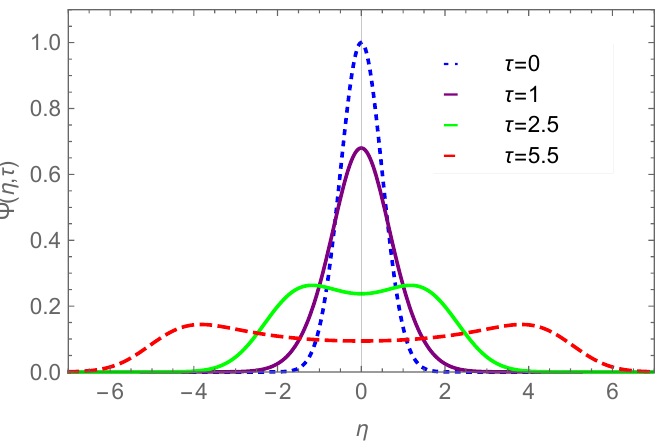
Figure 18. | Ψ ( η , τ ) | 2 vs. η for different values of τ , by reference to Equation